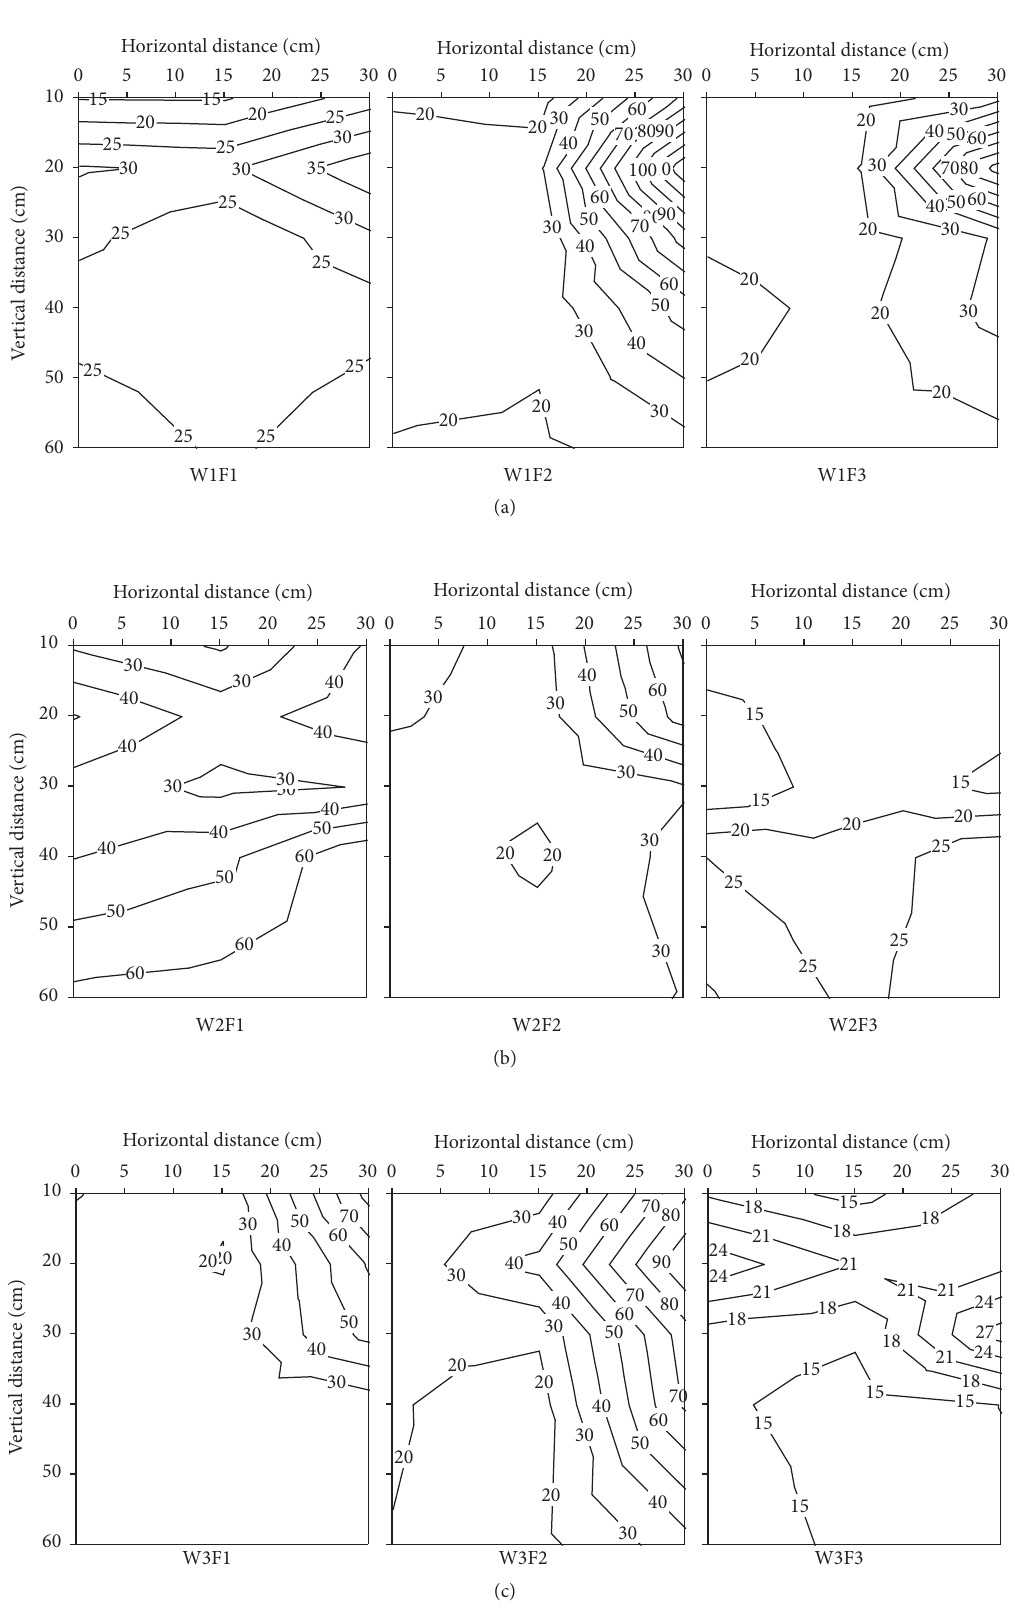
Figure 4: The effects of different irrigation and fertilization on vertical distribution of soil NO 3− -N content in root zone soil of different treatment at 43 days after transplanting in 2012. W1: 100% ET 0 , W2: 75% ET 0 , and W3: 50% ET 0 ; F1: N240–P 2 O 5 120–K 2 O150kg hm −2 ; F2: N180–P 2 O 5 90–K 2 O112.5 kghm −2 ; and F3: N120–P 2 O 5 60–K 2 O75 kg hm −2